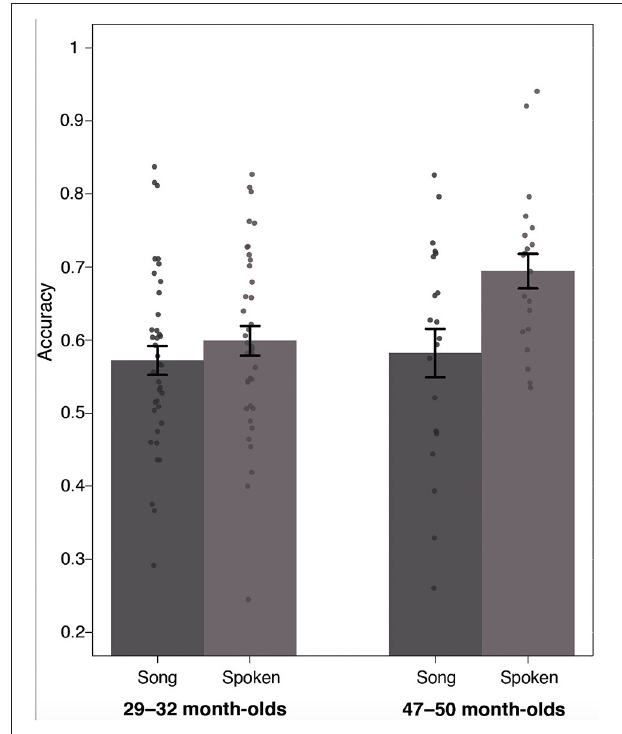
FIGURE 4 | Accuracy data based on proportion of looking to the correct object across the Song and Spoken conditions for both age groups.